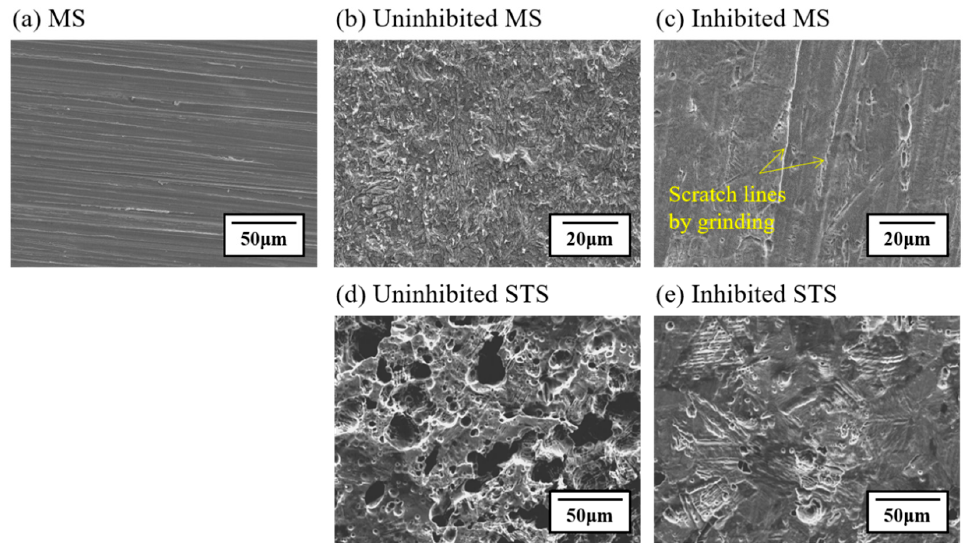
Figure 2. SEM micrographs for the corroded specimens immersed in 1 M HCl solution at 298 K containing 0.75 g/L of tea tree extract; ( a ) ground MS specimen without any treatment; ( b ) uninhibited MS; ( c ) inhibited MS; ( d ) uninhibited STS; ( e ) inhibited STS.